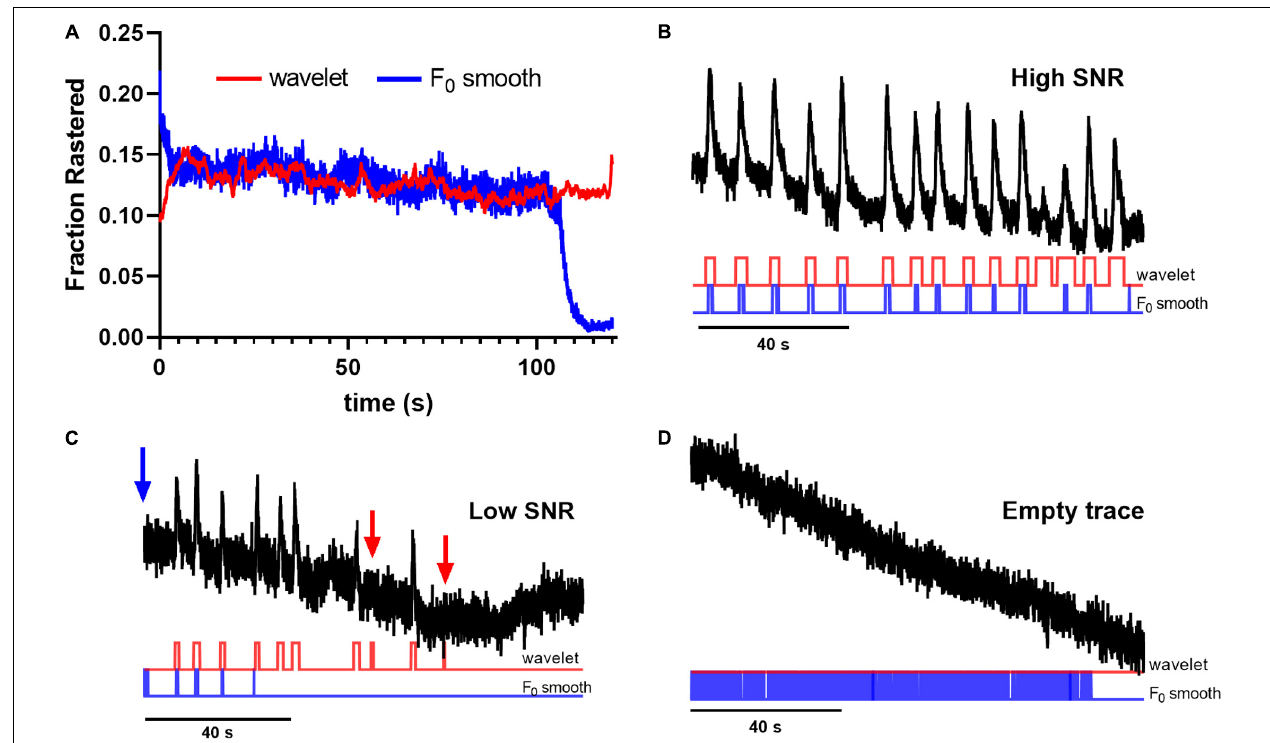
FIGURE 3 | Wavelet analysis outperforms F 0 smooth thresholding method for event identification. (A) Wavelet ridgewalking algorithm and F 0 smooth thresholding method produce similar raster probabilities. (B) In high signal-to-noise ratio (SNR) conditions, the two methods appear to identify almost identical events, but F 0 smooth finds those events to be shorter than wavelet ridgewalking. (C) In lower SNR conditions, the F 0 smooth thresholding method begins to fail, not identifying short spike events that wavelet ridgewalking readily detects. (D) F 0 smooth fails to identify “dead” ROIs whose traces contain no events, while wavelet analysis can be used to discard them. Red arrows indicate false events captured by wavelet ridgewalking, blue arrow indicates a false event captured by the F 0 smooth